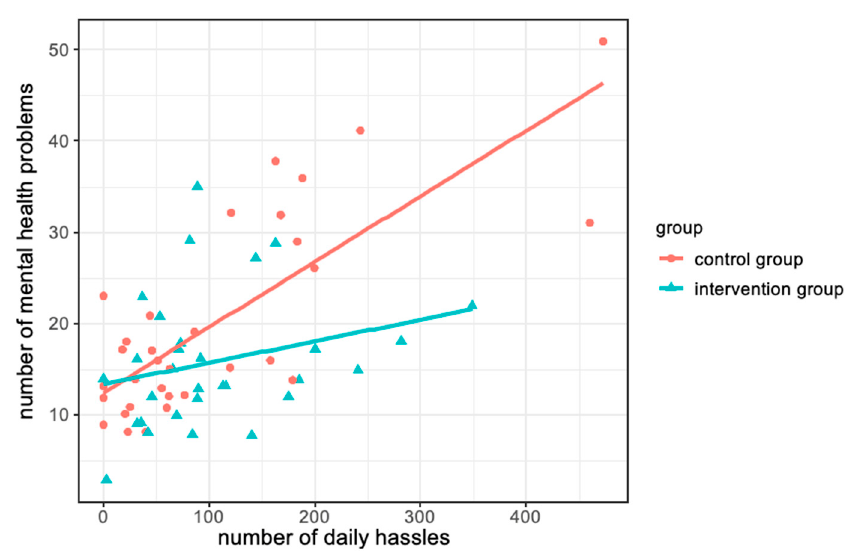
Figure A1. Relationship between stressor load and mental health at t1.